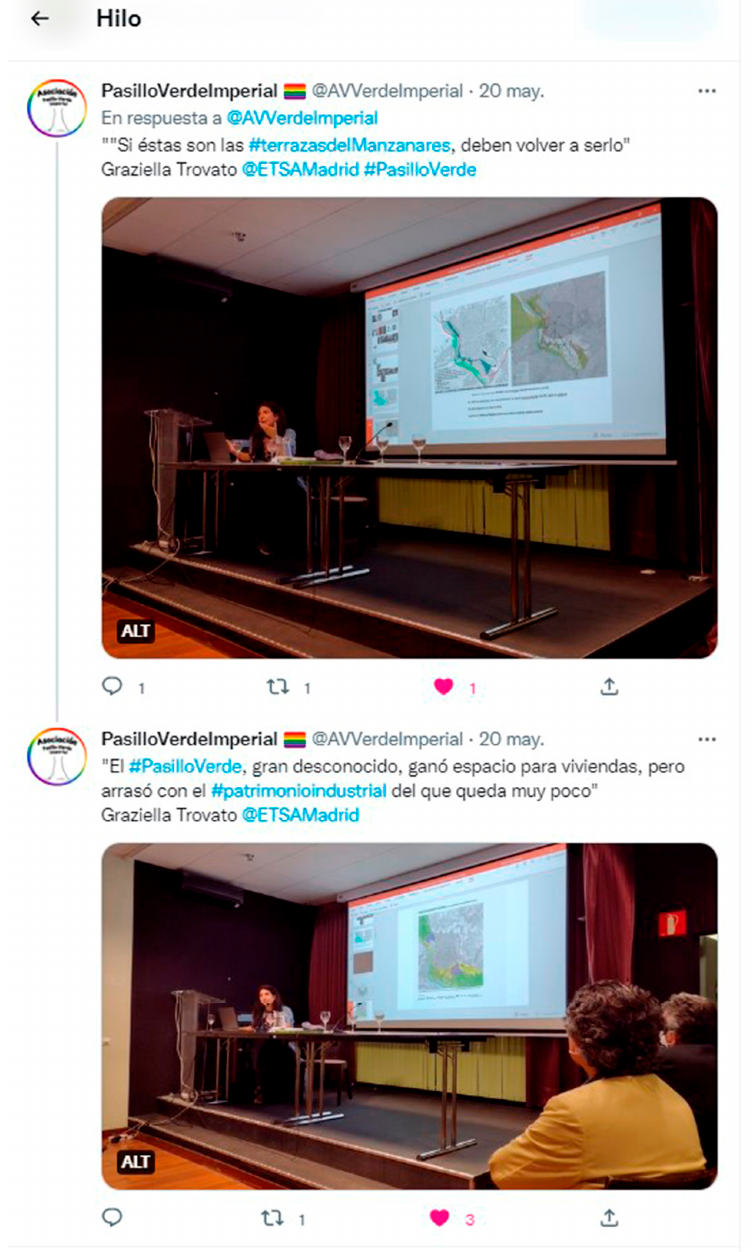
Figure 10. The presentation of the book Madrid, Between River and Rails [19] through a Twitter thread of the Neighborhood Association. The images show a projection screen with the PVF study area, analysis, and proposals. The neighbors shared and made the information and the objectives of the research their own. The tweets read: “ ‘If these are the #ManzanaresTerraces, they must be so again’ Graziella Trovato @ETSAMadrid #PasilloVerde” and “ ‘The #PasilloVerde, a great unknown, gained space for housing, but destroyed the #industrialheritage of which very little remains’ Graziella Trovato @ETSAMadrid”. Through the exhibition, the TRAHERE project is present on the social networks of the Madrid City Council (CentroCentro), including Twitter (15,400 followers), Instagram (22,900 followers), and Flickr, where a complete photographic report of the room is avail- able [21] (Figure 11).